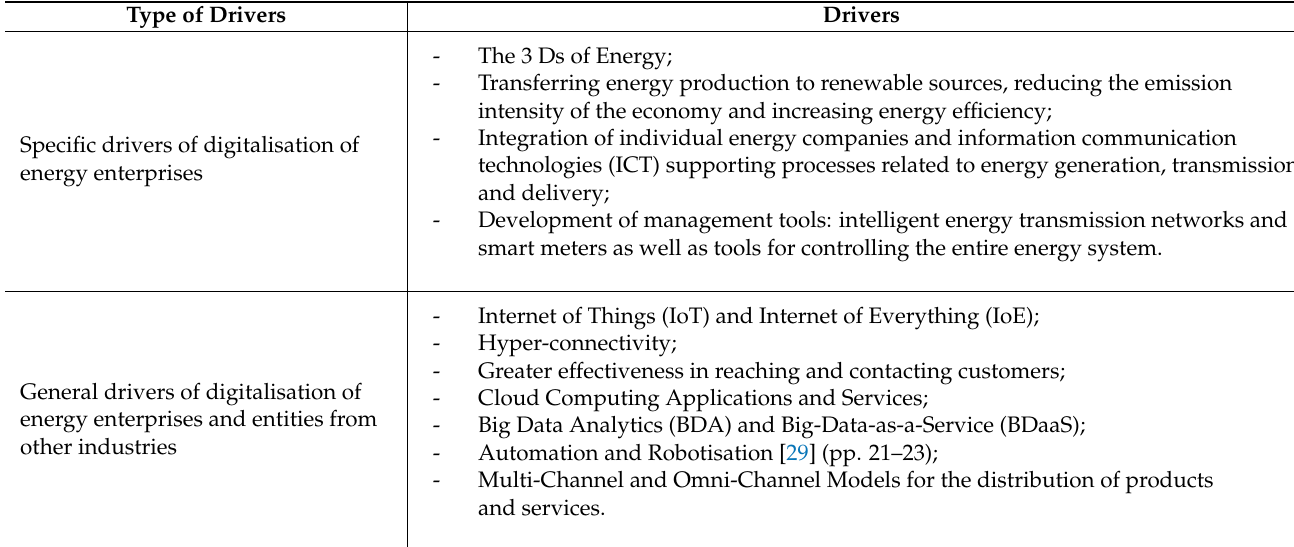
Table 1. Specific and general factors in the digitalisation of energy